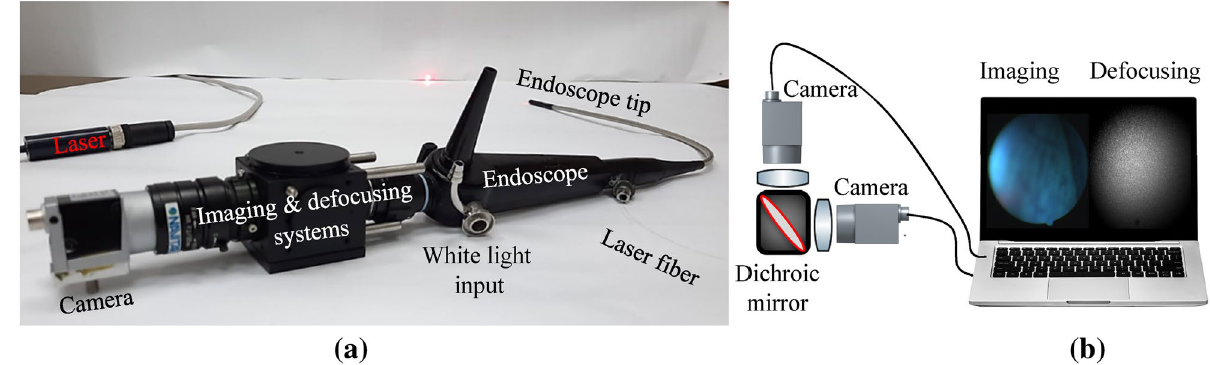
Figure 1. The optical setup for cilia motion characterization. ( a ) The setup consisted of an endoscope, a 650 nm fiber laser, an imaging system, and a defocusing system for speckle patterns. ( b ) The imaging system and the